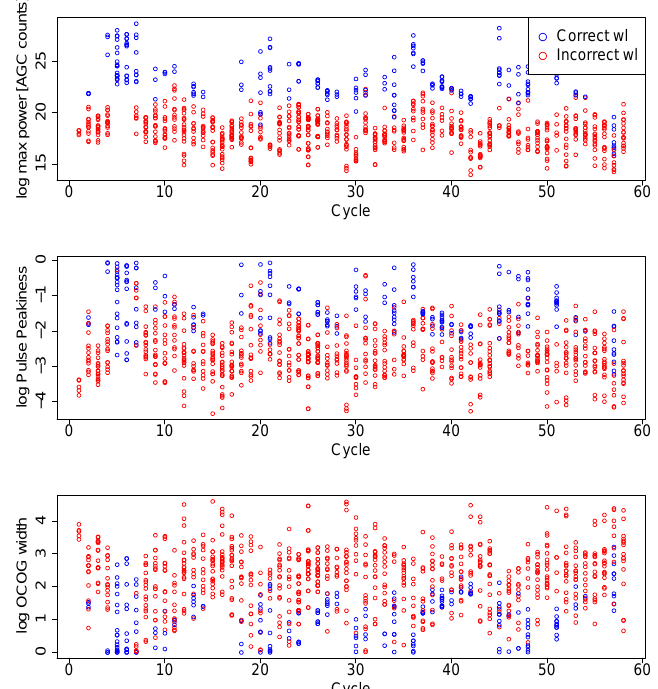
Figure A3. Waveform parameters; maximun power, pulse peakiness, and OCOG width as a function cycle for Lake Nonacho track number 360. Measurements are displayed in blue if the surface elevation agrees with in situ data and in red if